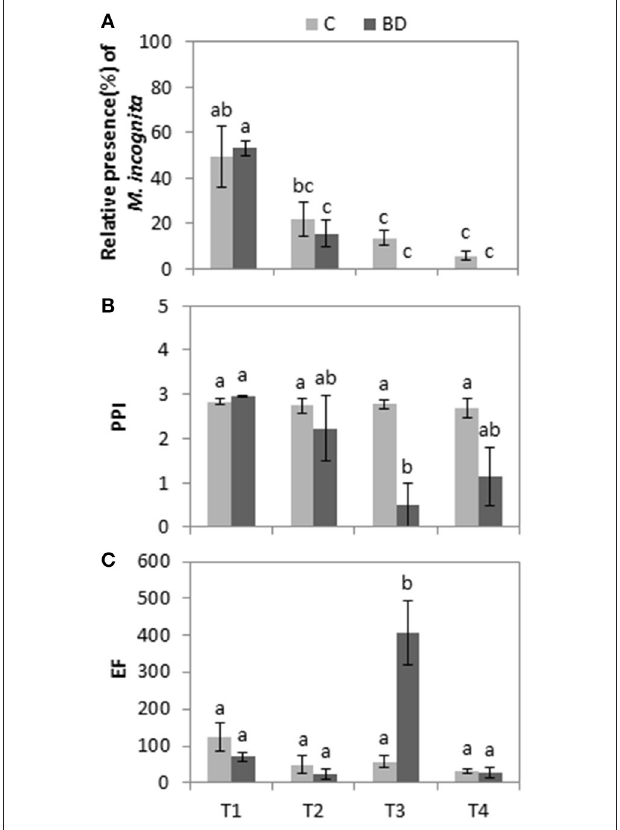
FIGURE 5 | (A) Relative presence (%) of Meloidogyne incognita. (B) Plan parasitic index (PPI). (C) Enrichment footprint (EF). Values at T1 (pre-treatment), T2 (post-treatment), T3 (post-crop after treatment) and T4 (1 year after treatment) in the biodisinfested (BD) and control (C) soils. Values with the same letter are not significantly different among time and treatment combinations according to Tukey HSD test ( P <